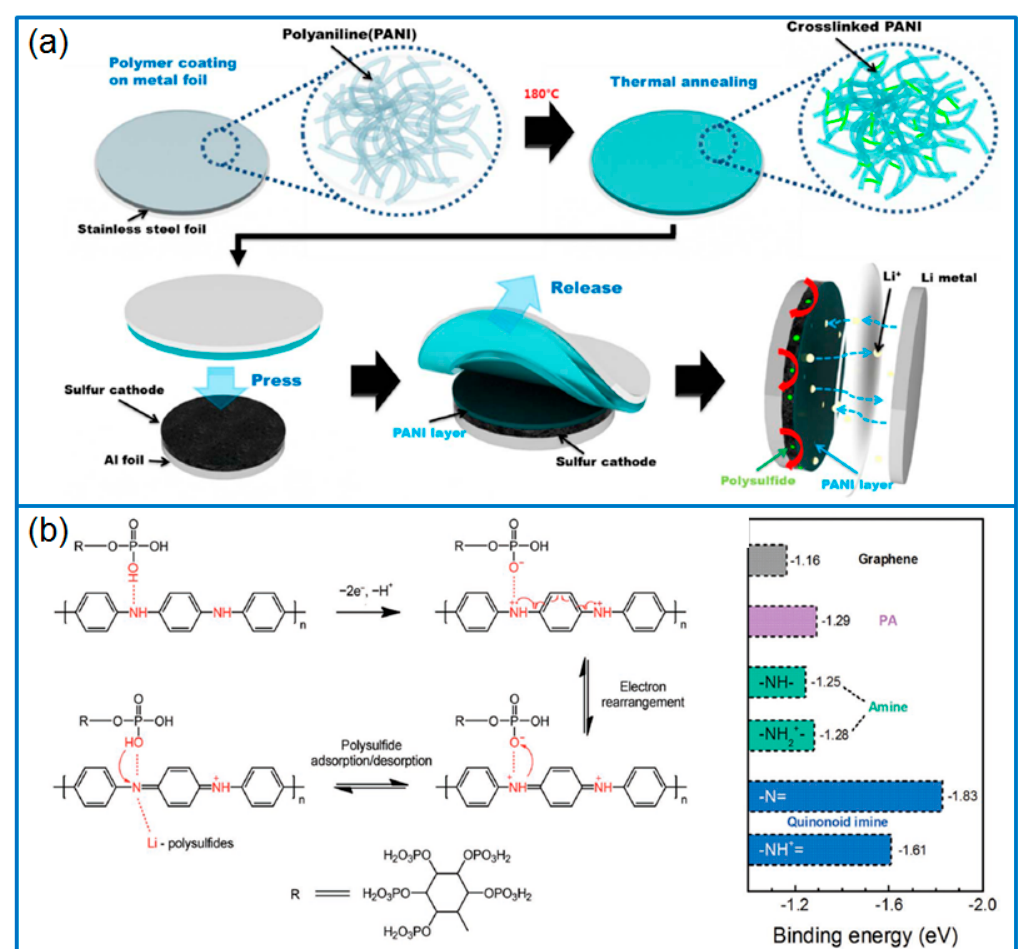
Figure 3. ( a ) Schematic illustration of PANI layer coated on sulfur cathode [48]; ( b ) The formation of quinonoid imines and the adsorption and desorption to polysulfides, and calculated binding energies of Li 2 S 8 on different matrices or functional groups [49].